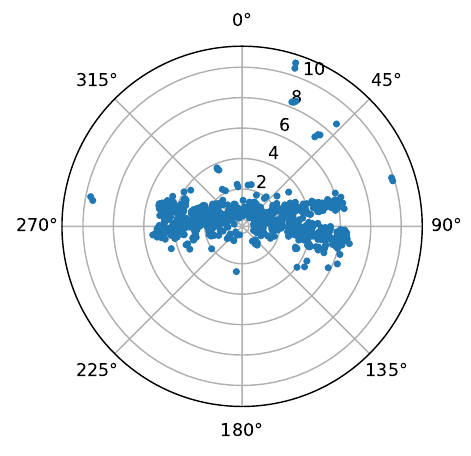
Figure 2. Skyplot showing the incidence and azimuth angles of the PlanetScope imagery. Only few images with incidence angles larger than 6 ◦ are available.